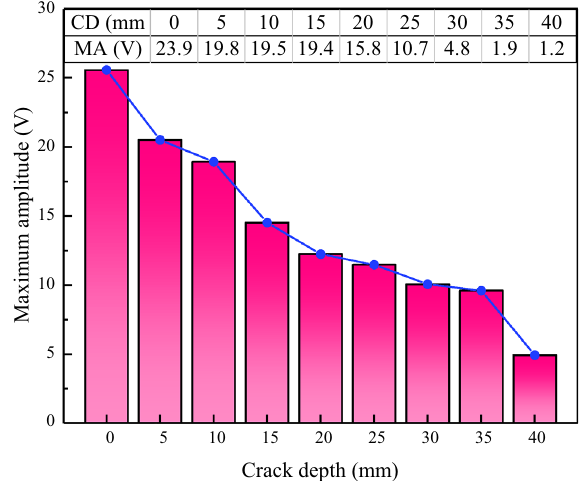
Figure 13. The maximum value of the signal at different crack depths.